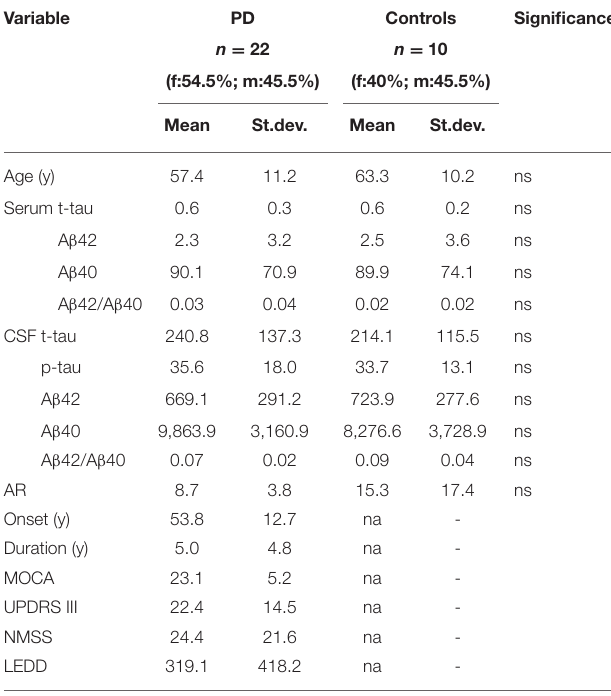
TABLE 1 | Clinical and biochemical data of the study population. Variable PD